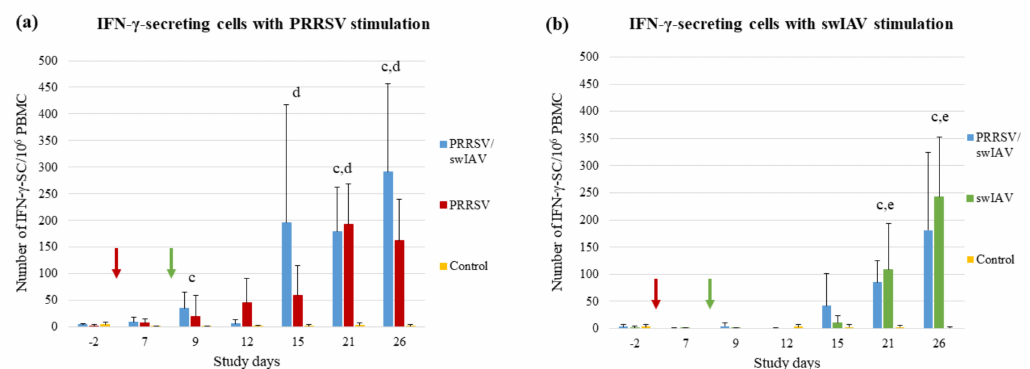
Figure 6. Cell-mediated immune response. Number of IFN- γ -secreting cells per million PBMCs after ( a ) PRRSV stimulation, or ( b ) swIAV stimulation. Data are reported as the means ( ± standard deviation) of results obtained from pigs ( n = 6) in the PRRSV/swIAV (blue), PRRSV (red), swIAV (green) or Control (yellow) groups. Letters indicate that significant differences (with p < 0.05) were obtained between PRRSV/swIAV and (a) PRRSV and (b) swIAV and (c) Control groups and (d) and (e) between PRRSV and swIAV and the Control groups (respectively), SD0 (red arrow): PRRSV inoculation; SD8 (red arrow): swIAV